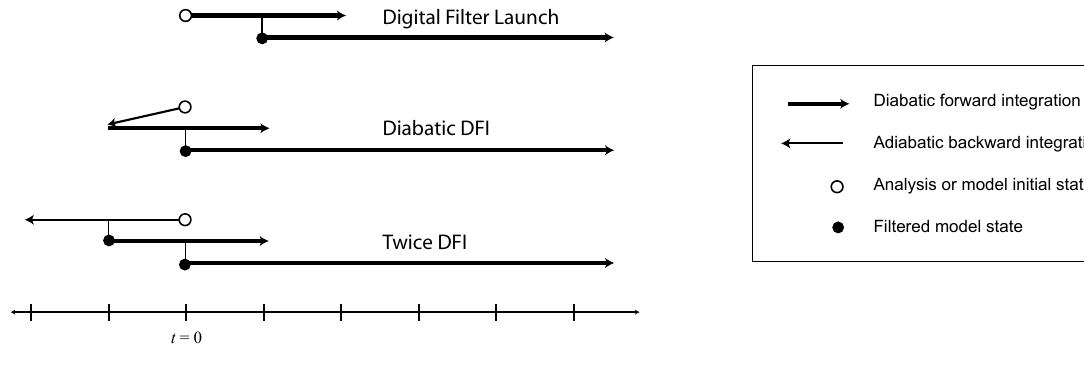
Figure 5.2: An illustration showing the three available DFI schemes: digital filter launch, dia- batic digital filter initialization, and twice digital filter